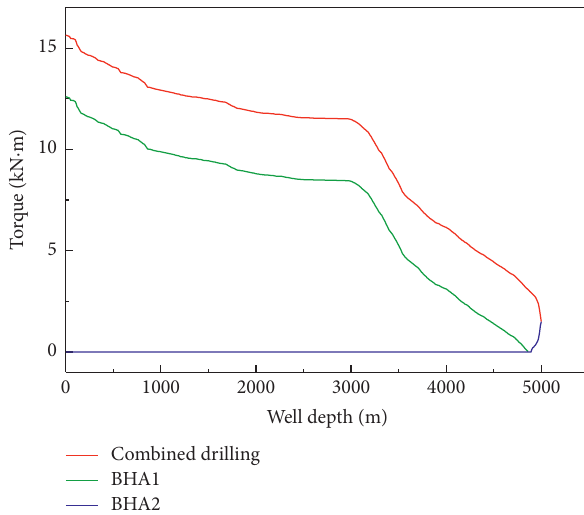
Figure 10: Relationship between torque and well depth.